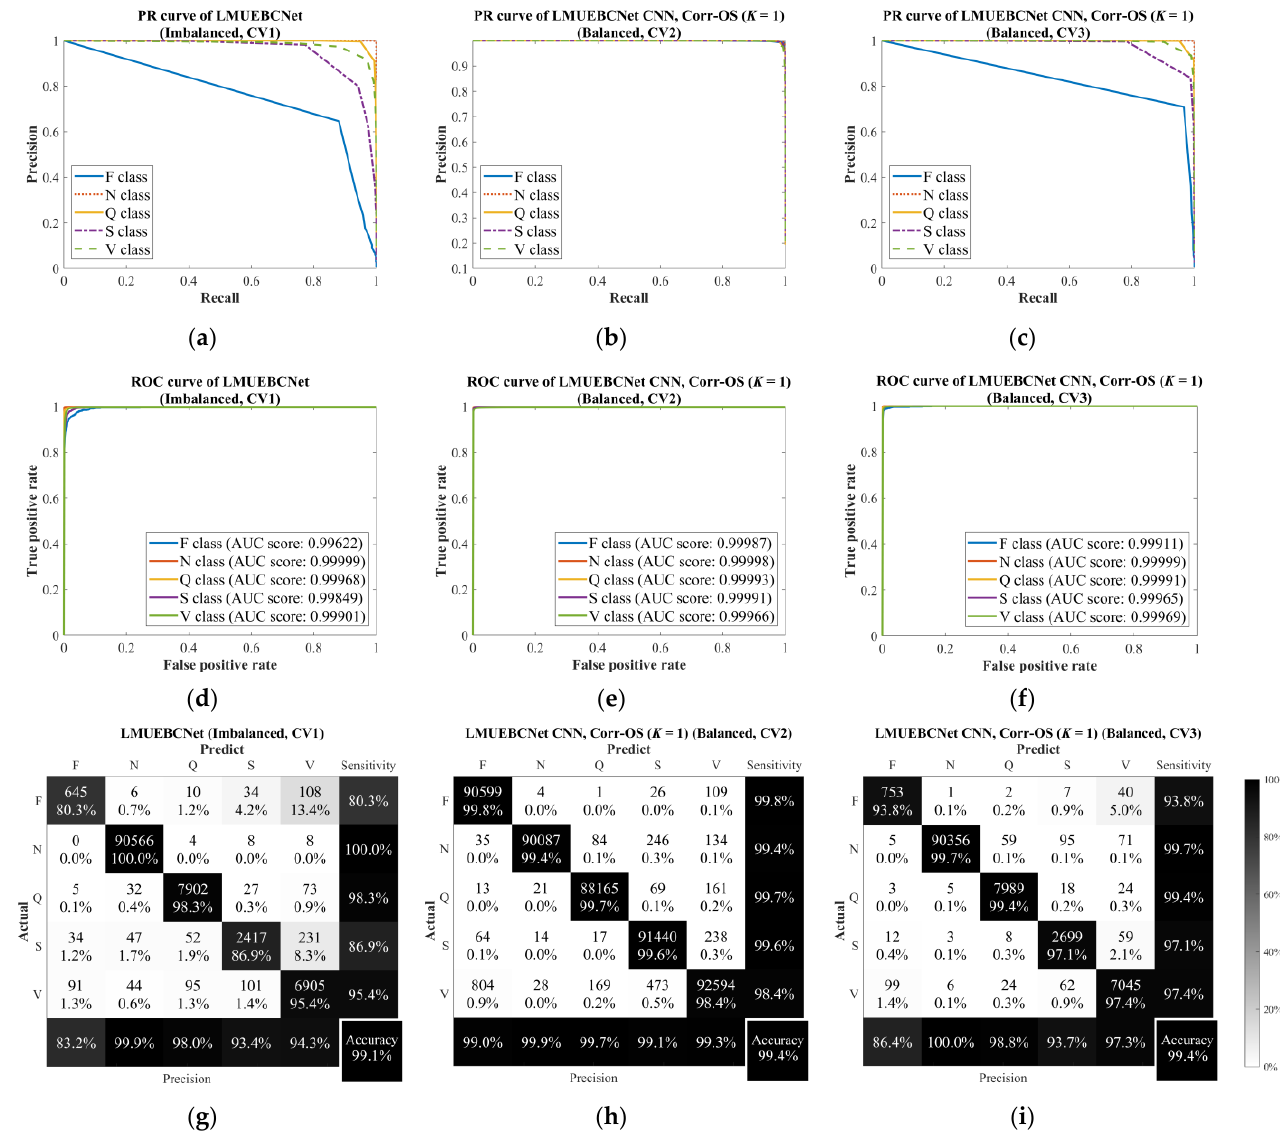
Figure 4. ROC curves and AUC scores of LMUEBCNet in ( a ) CV1, ( b ) CV2 of Corr-OS ( K = 1), and ( c ) CV3 of Corr-OS ( K = 1); PR curves of LMUEBCNet in ( d ) CV1, ( e ) CV2 of Corr-OS ( K = 1), and ( f ) CV3 of Corr-OS ( K = 1); confusion matrix of LMUEBCNet in ( g ) CV1, ( h ) CV2 of Corr-OS ( K = 1), and ( i ) CV2 of Corr-OS ( K = 1).